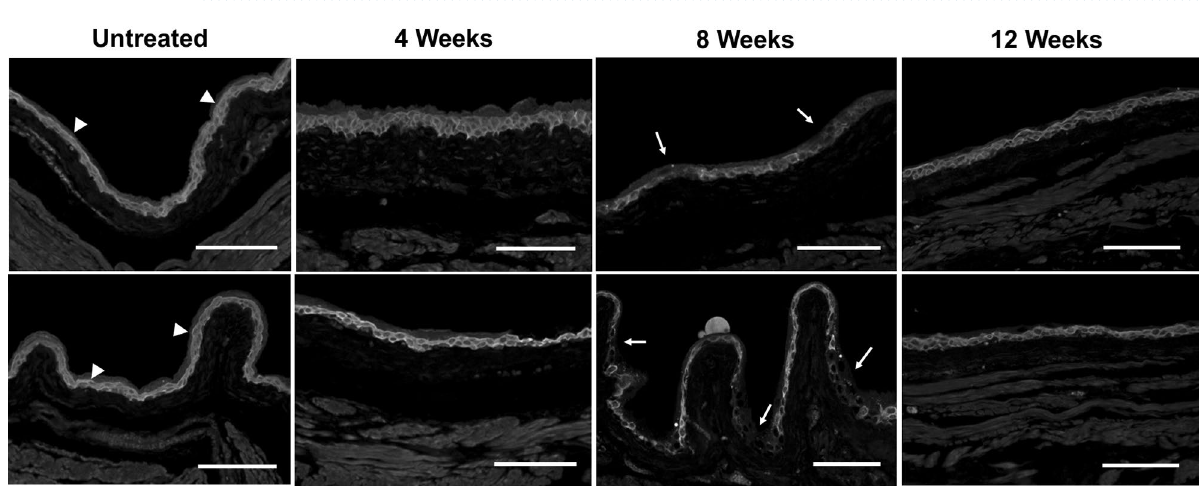
Figure 4. Transient loss of tight junction protein ZO-1 at 8 weeks after irradiation. Bladder sections of untreated and irradiated bladders at 4, 8 and 12 weeks were stained for ZO-1 using immunofluorescence. Arrow heads: positive staining for ZO-1 in the urothelium; Arrows: areas of negative staining for ZO-1. Scale bar = 100